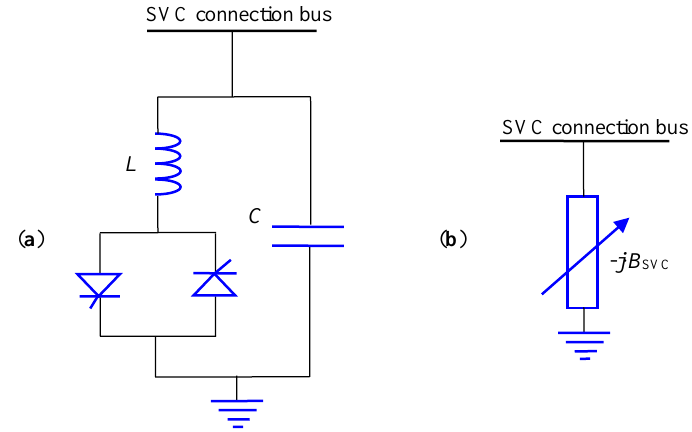
Figure 1. A Static Var Compensator (SVC). ( a ) circuit structure and ( b ) equivalent model.